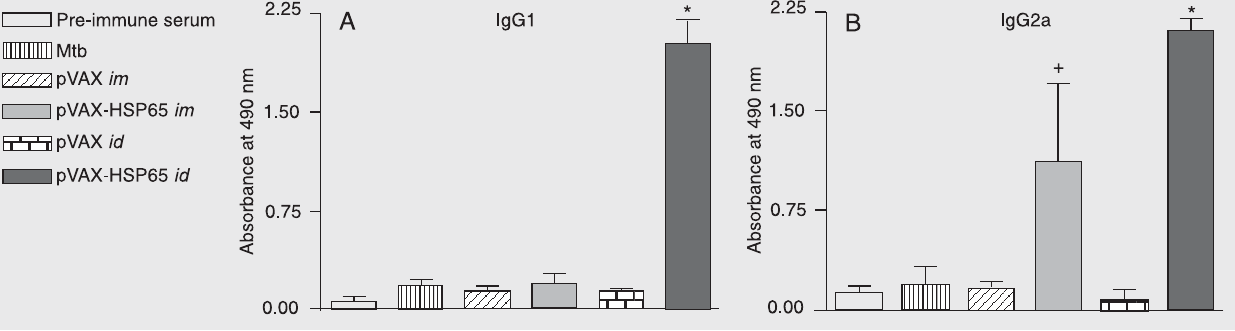
Figure 2. Serum antibody levels. Female C57BL/6 mice (4-6 mice per group) were fed for 105 days an atherogenic diet (high cholesterol diet, HCD) associated with 3 doses of 250 µg heat-killed M. tuberculosis (Mtb) on days 0, 15, and 30. On day 105, the animals started to receive a normal chow diet and were immunized with DNA (4 doses of 100 µg pVAX-HSP65) administered by the intramuscular ( im ) or intradermal ( id ) route on days 105, 115, 125, and 135. The following control groups (4-6 mice per group) were included: Mtb (animals fed the HCD and immunized with Mtb); pVAX im and pVAX id (animals fed the HCD, immunized with Mtb and injected with the empty vector by the im or id route). Pre-immune serum was collected before immunizations with DNA (105th day) and immune serum was collected 15 days after the last immunization (150th day) for the detection of IgG1 (A) or IgG2a (B) anti-Hsp65 antibodies by ELISA. Data are reported as mean ± SEM for 4-6 animals per group. *P < 0.05 compared with all other groups, + P < 0.05 compared with the pre-immune, Mtb and pVAX-HSP65 id groups (ANOVA followed by Tukey test) .